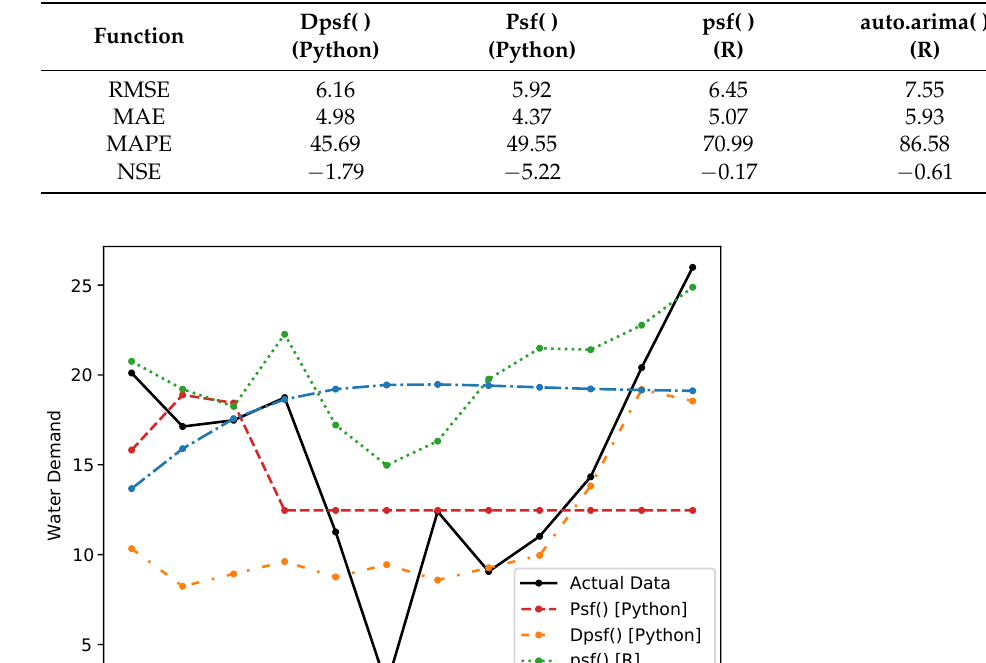
Figure 8. Result of dpsf_plot() for the “Water Demand” dataset. Table 6. Comparison of forecast methods with different error metrics for the “Water Demand” dataset.